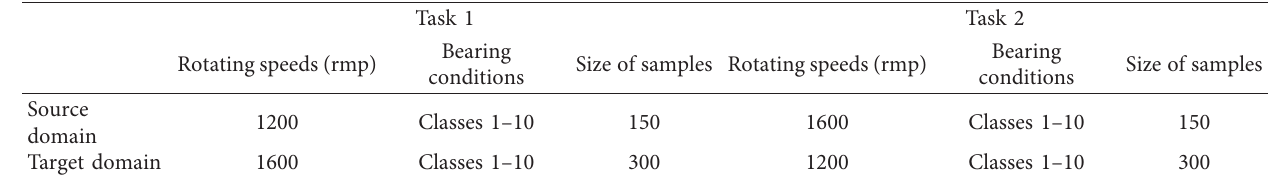
Table 8: 2 cross-domain fault diagnosis tasks for 10 bearing